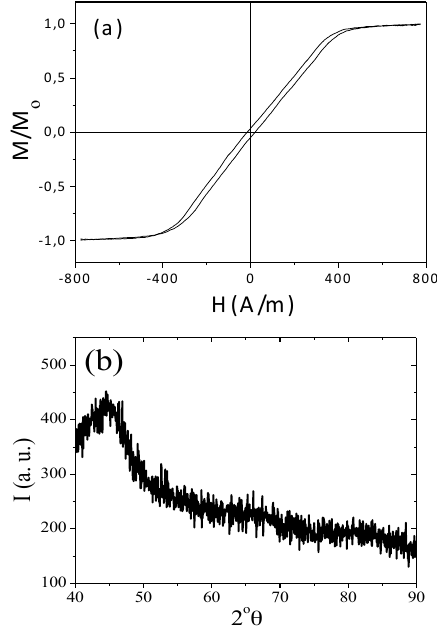
Figure 1: Hysteresis loop (a) and XRD patterns (b) of as-prepared Co microwire